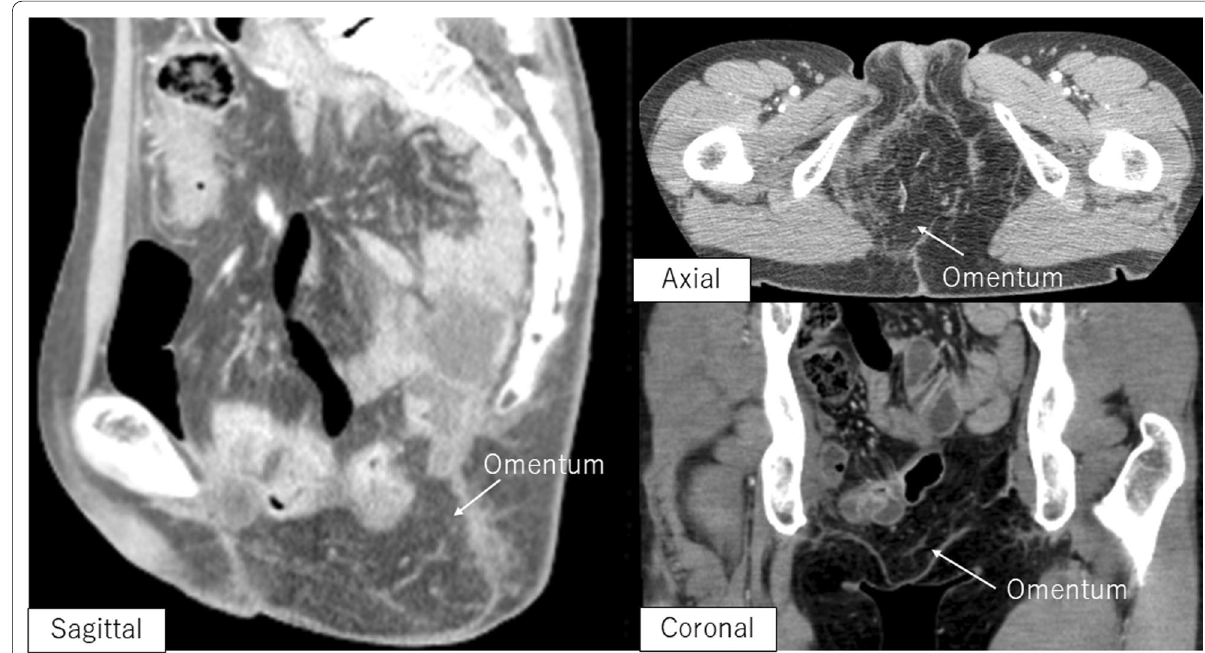
Fig. 5 Postoperative computed tomography scan. The dead space in the ischiorectal fossa is filled with omentum. No perineal hernia is